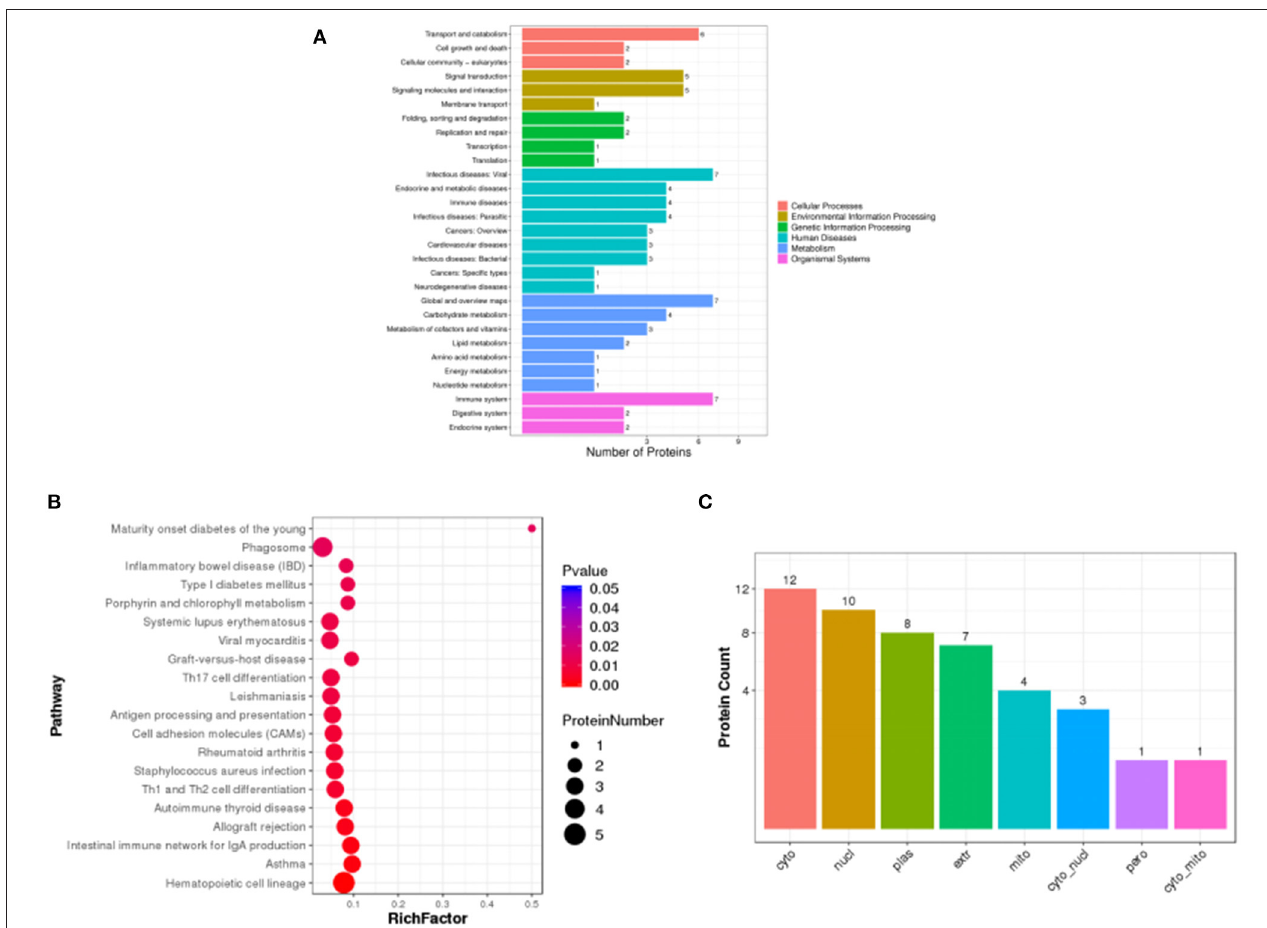
FIGURE 6 | Statistical plots of Pathway classification of differential proteins (A) , statistical plots of significantly enriched pathway (B) and histogram of subcellular localization (C) in HD and MC